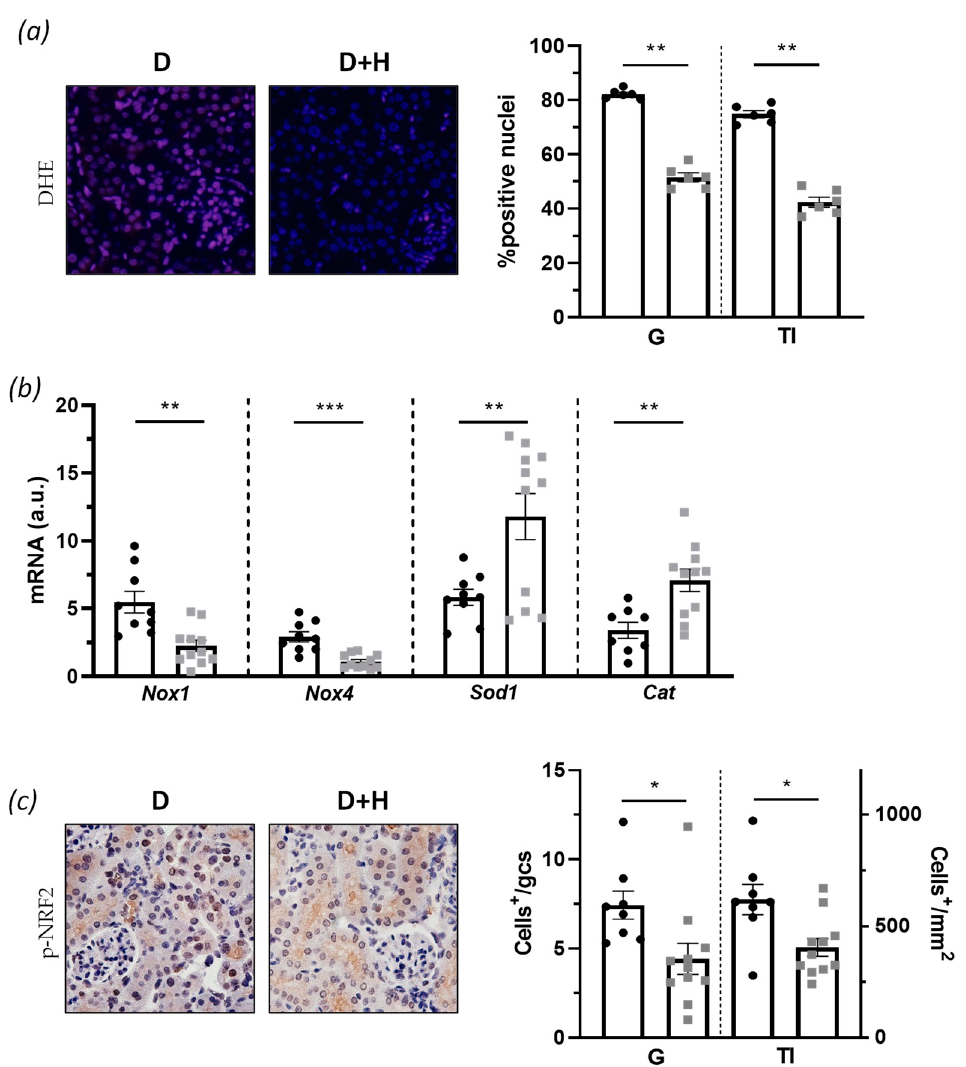
Figure 5. Antioxidant effect of hidrosmin in the diabetic kidney: ( a ) representative images of kidney sections stained with DHE in red, and DAPI in blue (merged images; magnification x400) and quantification of positive cells in renal sections from untreated control (D) and hidrosmin-treated (D + H) mice; ( b ) real-time PCR analysis of prooxidant ( Nox1 and Nox4 ) and antioxidant ( Sod1 and Cat ) genes. Values normalized to 18S are expressed as arbitrary units (a.u.); ( c ) representative images (magnification × 400) of p-NRF2 immunodetection and quantification of positive cells in glomeruli (G) and tubulointerstitium (TI) of diabetic mice. Bars represent individual values and the mean ± SEM of n = 8–9 animals (D group) and n = 11 animals (D + H group). * p < 0.05, ** p < 0.01, and *** p < 0.001 vs.